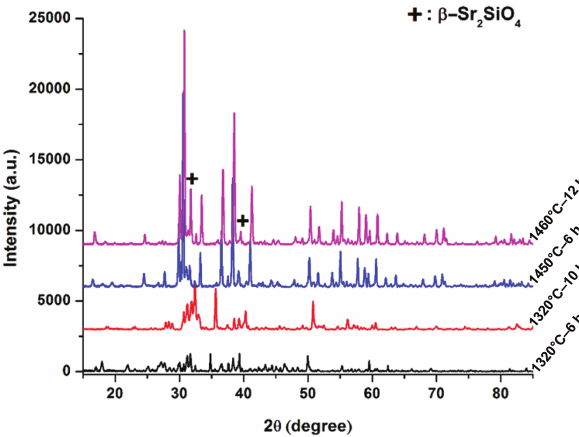
Figure 5: The XRD patterns at different sintering temperatures of Sr 3 SiO 5 : Eu 3+ , Dy 3+ , Mg 2+